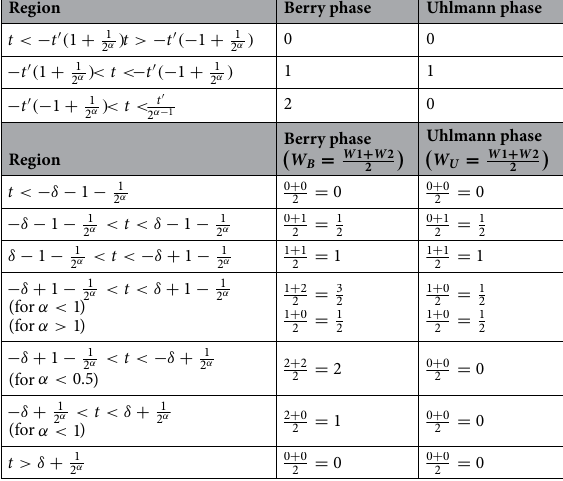
Table 2. A comparison of different pure and mixed state geometric phases of extended-range SSH chain for 2 ). The top and bottom tables represent the Hermitian and non-Hermitian SSH two nearest neighbors ( r = chains respectively. The Berry phase and Uhlmann phases are calculated through Eqs. (4) and (10) respectively. 1 Here the geometric phases are quantized in the units of π with t ′ =